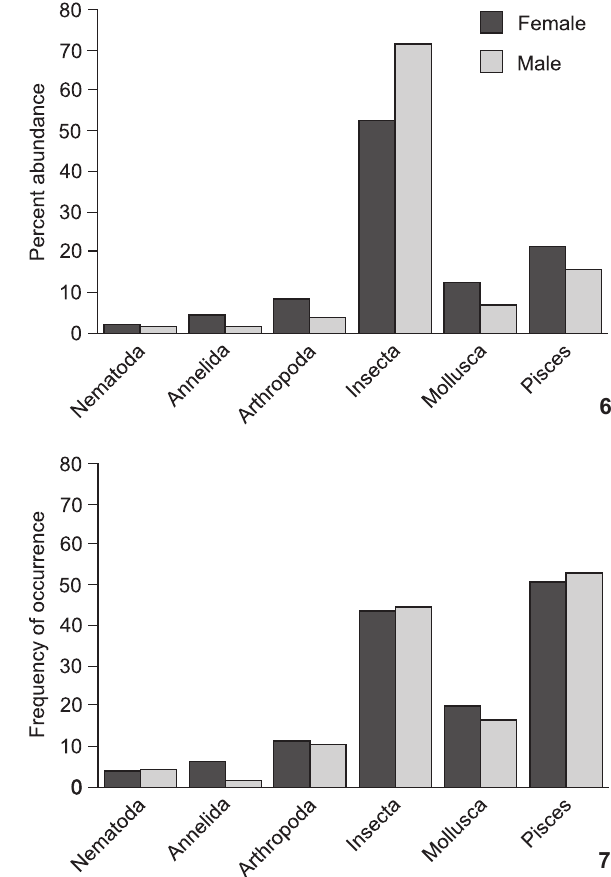
Figures 6-7. Variation between the sexes in the percentage values of abundance (6) and occurrence frequency (7) of food items found in the stomachs of Trachelyopterus lucenai captured in Itapeva, Quadros and Malvas lagoons in the Tramandaí River system, Rio Grande do